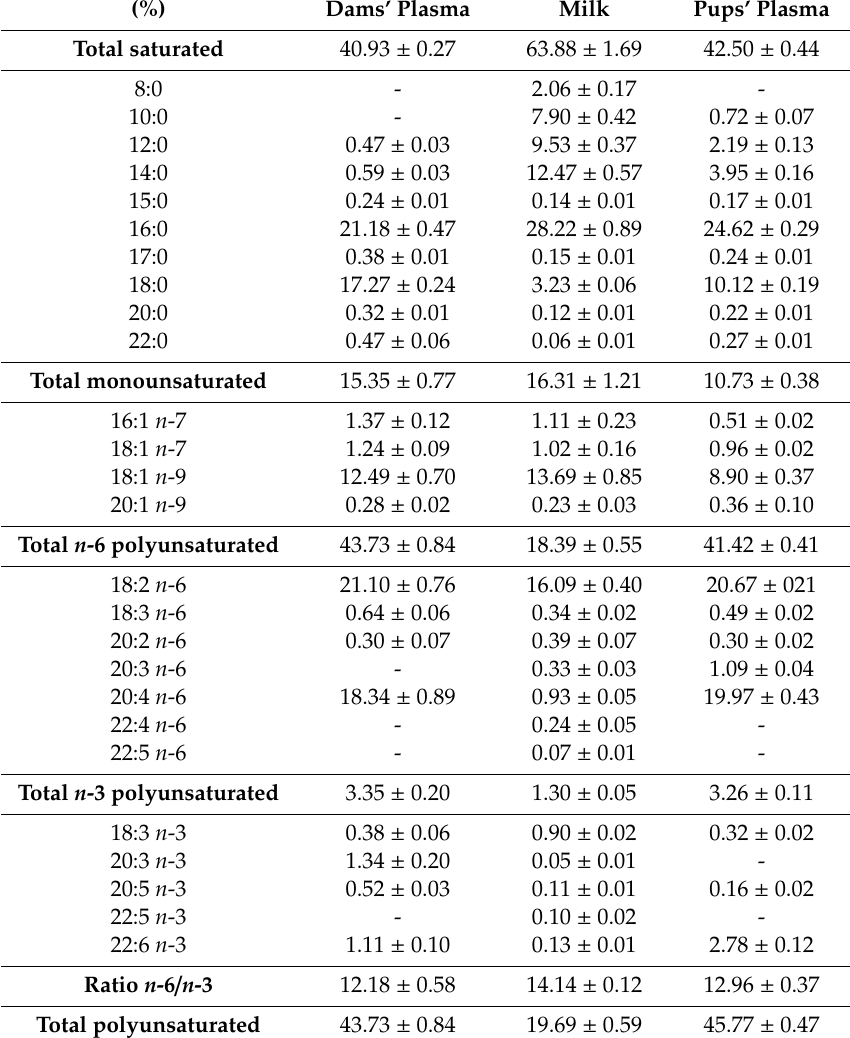
Table 1. Fatty acids (FA) composition of milk and plasma of dams and